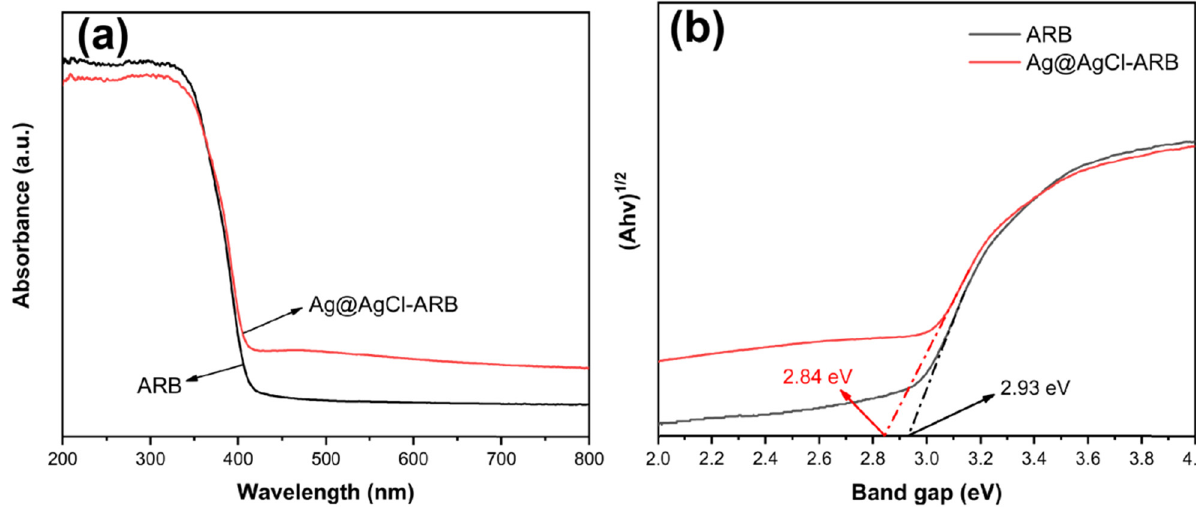
Figure 6: UV - visible absorption spectra ( a ) and band gap ( b ) of the samples.